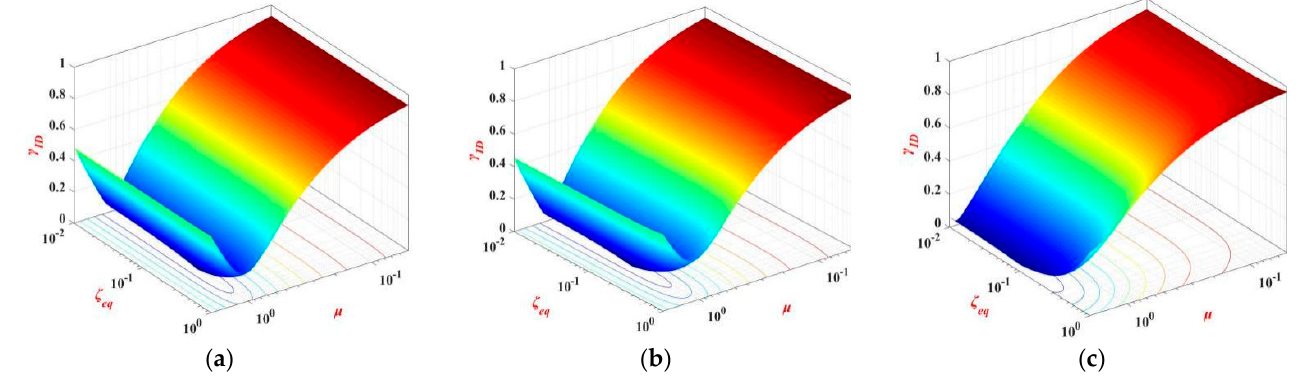
Figure 8. Contour plot of γ U of LB–1 : ( a ) κ = 0.05; ( b ) κ = 0.1; ( c ) κ = 0.3.